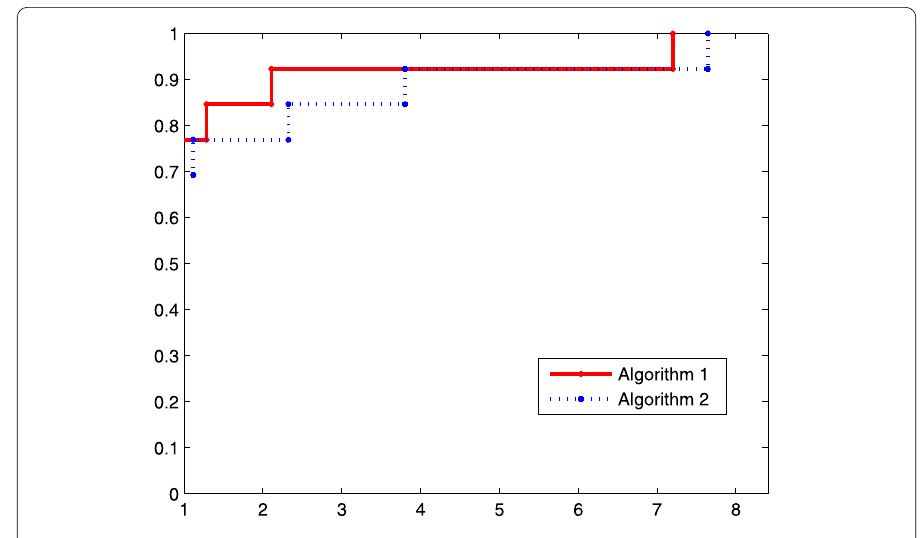
Figure 1 Performance profiles of the total number of iterations of two algorithms ( n = 100).